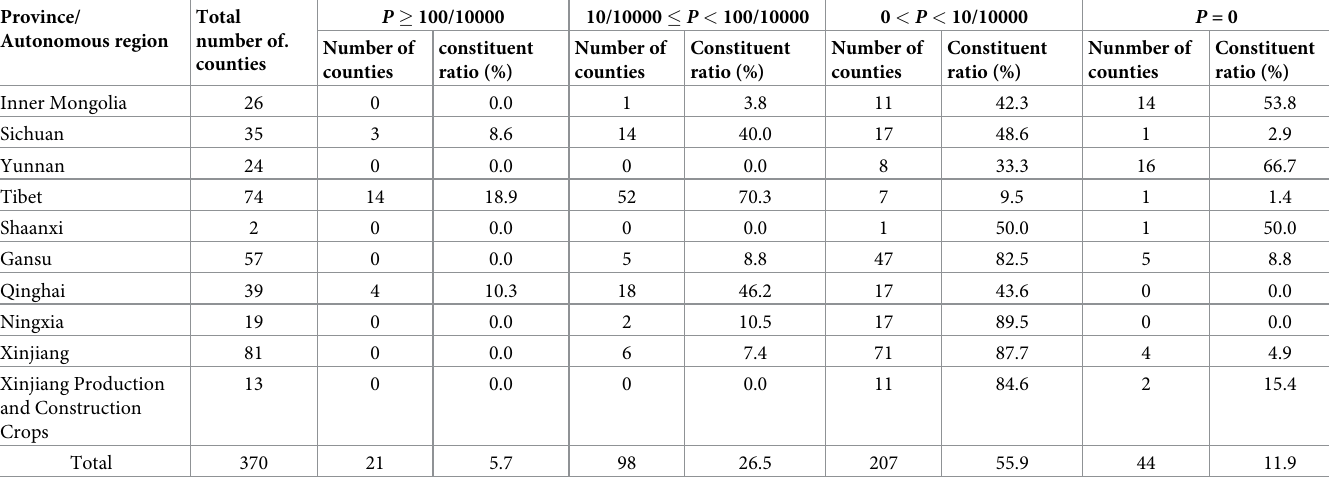
Table 3. Classification of the prevalence rate for human CE in China, 2018. Province/ Total Autonomous region number